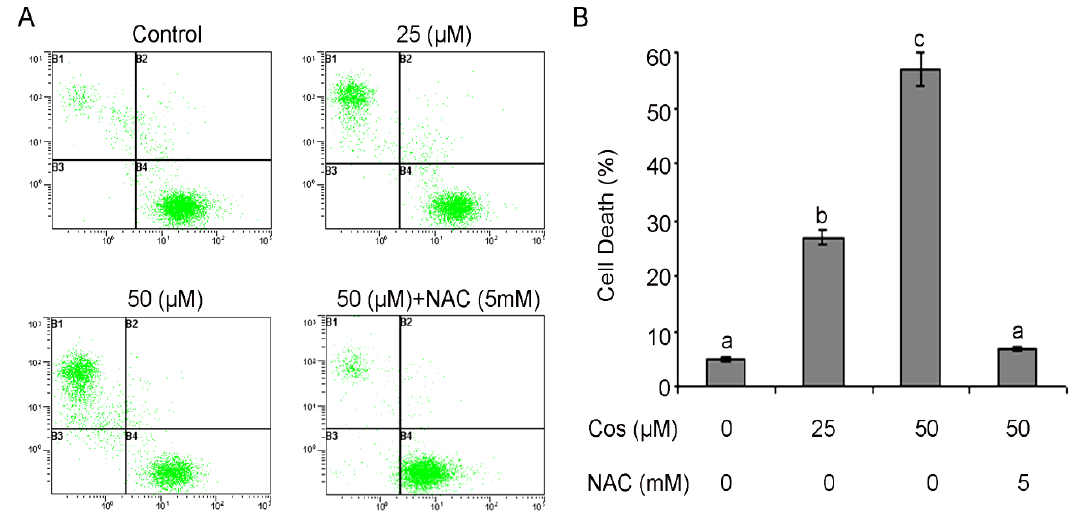
Figure 4. Determination of cell viability by calcein/PI staining and flow cytometry. ( A ) T24 cells were treated with 25 and 50 µM of costunolide in the presence or absence of NAC for 24 h. Histograms show number of PI positive cells ( y -axis) vs. calcein positive cells ( x -axis). The data shown are representative of three independent experiments with the similar results. ( B ) Data are expressed as Mean ± SD (n = 3). Columns not sharing the same superscript letter differ significantly ( p < 0.05).